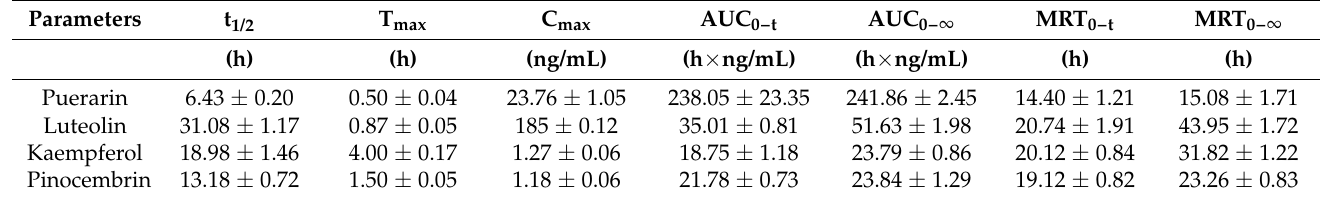
Figure 15. Blood concentration–time curve of four analytes after oral administration of the aerial parts of G. uralensis. ( a ) Puerarin; ( b ) luteolin; ( c ) kaempferol; ( d ) pinocembrin (d—day; h—hour; the time before administration on day 31 was taken as the y-axis position, before the y-axis indicates the concentration at different days, and after the y-axis represents the concentration at different time points after the last day of administration). Table 7. Mean pharmacokinetic parameters for four analytes in rat plasma after oral administration of the aerial parts of G. uralensis extract at 31 days ( n =